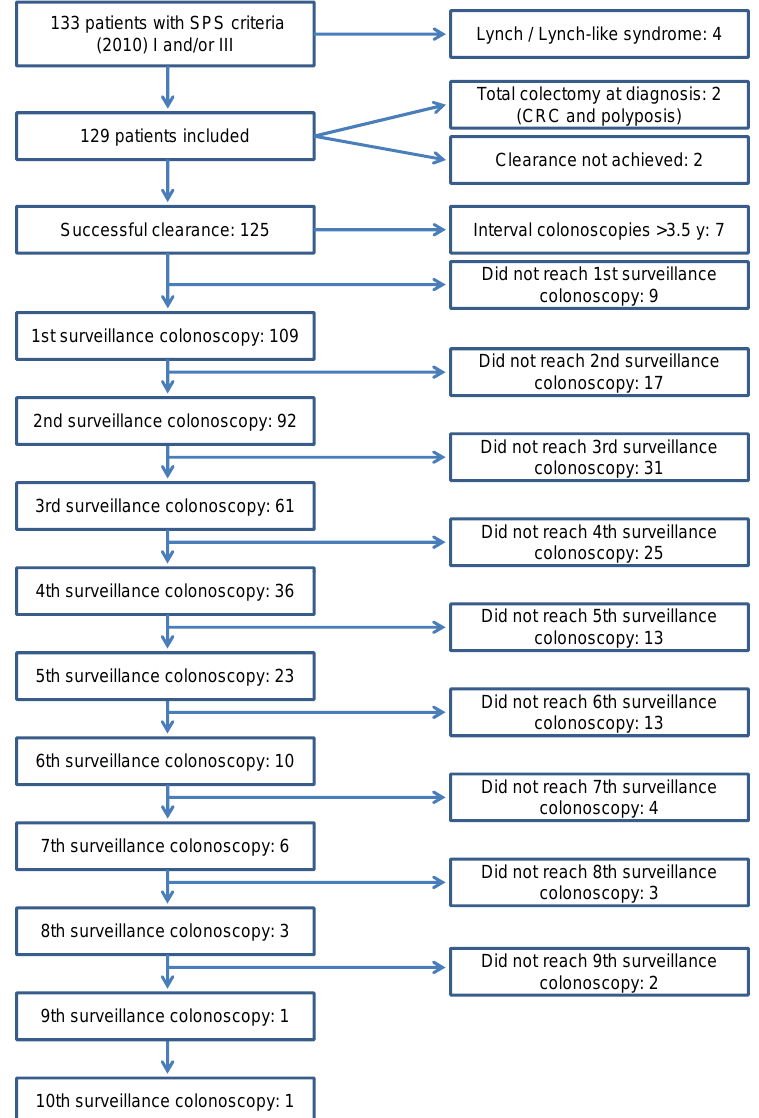
Figure 1. Flow chart of patients during the study